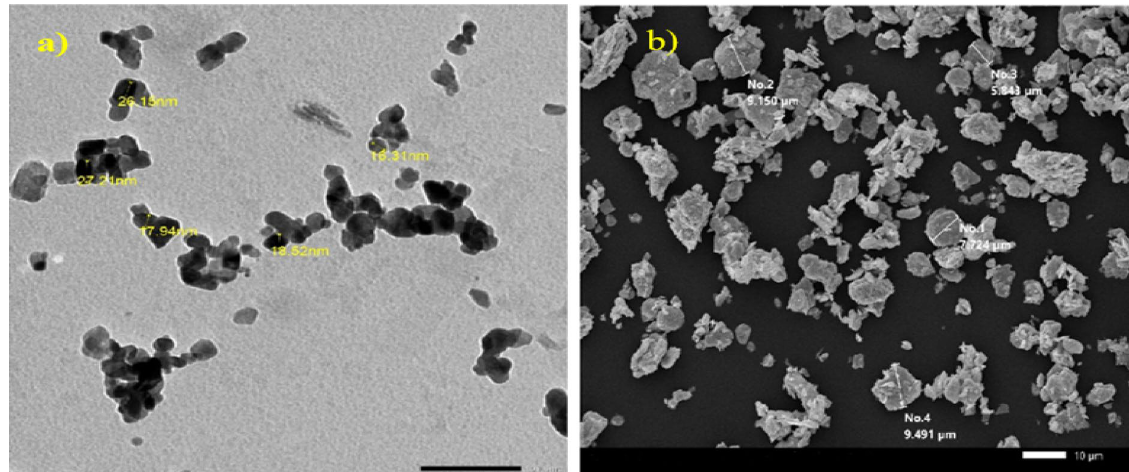
Figure 2. ( a ) TEM image of nano-Tin oxide particles, and ( b ) SEM image of micro-Tin oxide.